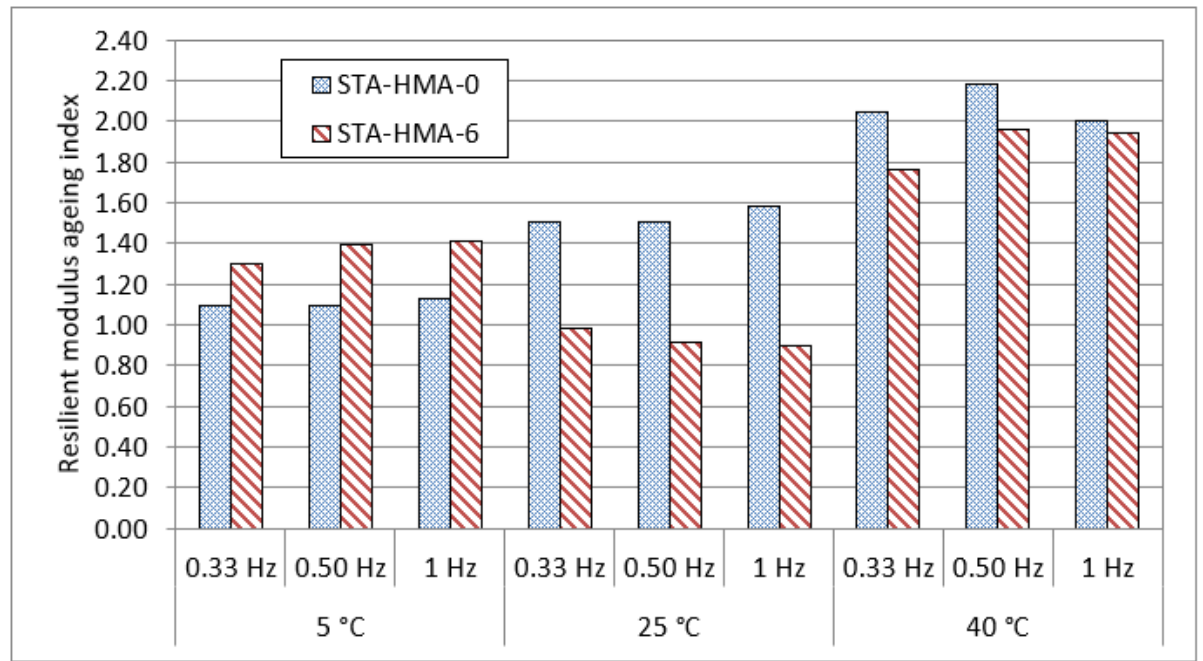
Figure 6. Resilient modulus ageing index of short-term aged Figure 6 . Resilient modulus ageing index of short-term aged mixes.